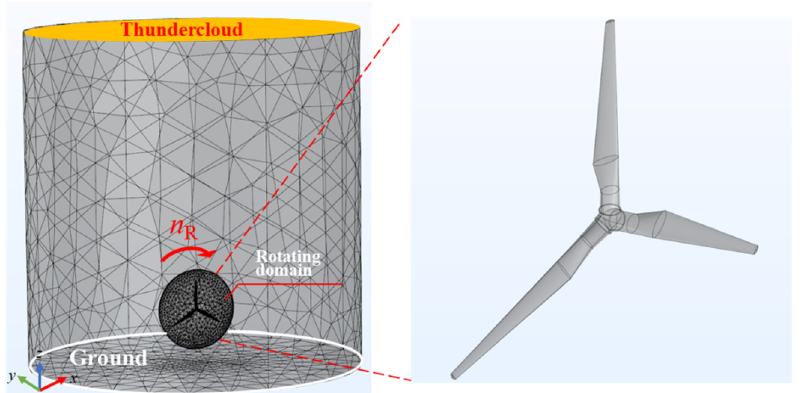
Figure 1. Schematic diagram of calculation domain.